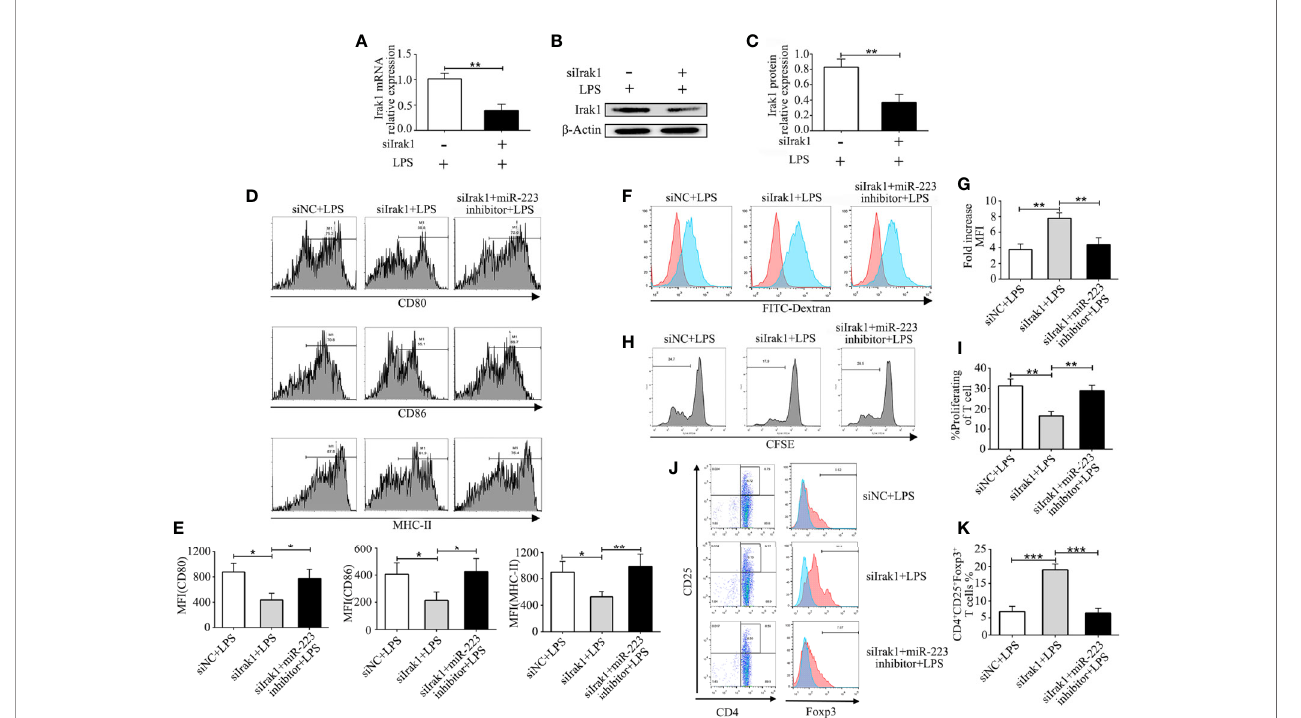
FIGURE 5 | MiR-223 regulates DC function via Irak1. BMDCs were transfected with siNC, siIrak1, and siIrak1+miR-223 inhibitor for 6 h before being stimulated with LPS. (A) The mRNA levels of Irak1 were examined by qRT-PCR. (B, C) Protein expression of Irak1 was determined by western blotting. b -actin was used as a loading control. (D, E) BMDCs were stained with directly conjugated CD80, CD86, and MHC-II and analyzed by fl ow cytometry. (F) Phagocytic ability of siR-NC imBMDCs, siIrak1-imBMDCs, and siIrak1+miR-223 inhibitor imBMDCs after LPS stimulation as tested by measuring phagocytosis using FACS. (G) Quantitative assessment of the phagocytic ability of siR-NC imBMDCs, siIrak1-imBMDCs, and siIrak1+miR-223 inhibitor imBMDCs after LPS stimulation. (H) Representative FACS results of three independent experiments for CD4 + T-cell proliferation. (I) Quantitative assessment of CD4 + T-cell proliferation in three groups. (J) Representative FACS results of three independent experiments for the percentage of Tregs. (K) Quantitative assessment of the percentage of Tregs in three groups. Data are presented as mean ± SD and represent three experiments. *P < 0.05; **P < 0.01; ***P <